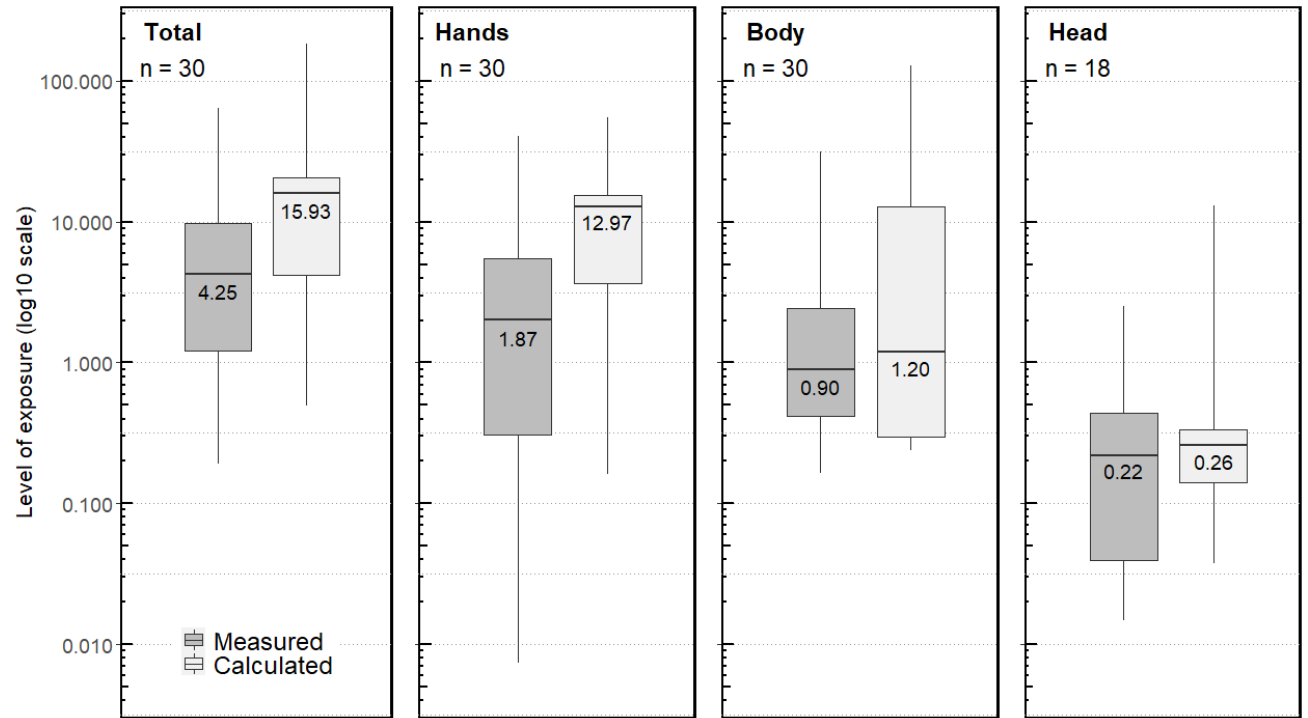
Figure 1. Daily exposure (mg/day) overall (total: hands + body + head) and according to body parts, calculated using the AOEM and measured in the CANEPA study.